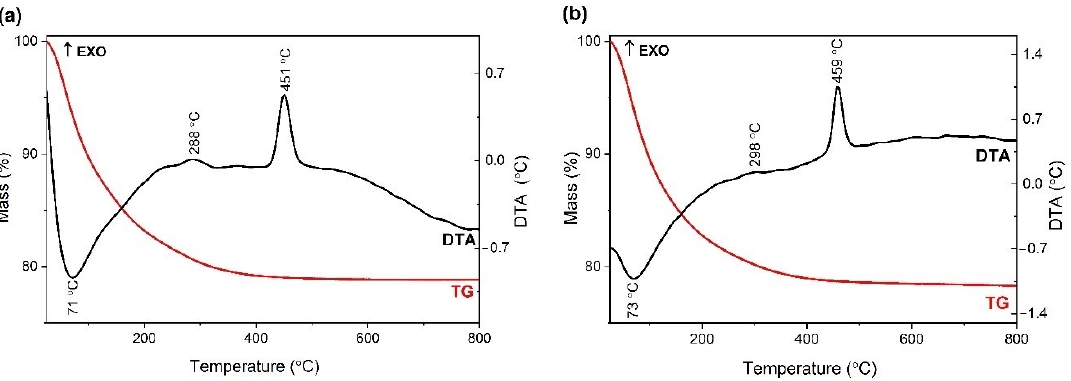
Figure 4. The TG (red)/DTA (black) curves of ( a ) TiO 2 − Cu 2.0% sample and ( b ) TiO 2 − Zn 2.0% sample; heating rate was 10 °C/min and using air as carrier gas.